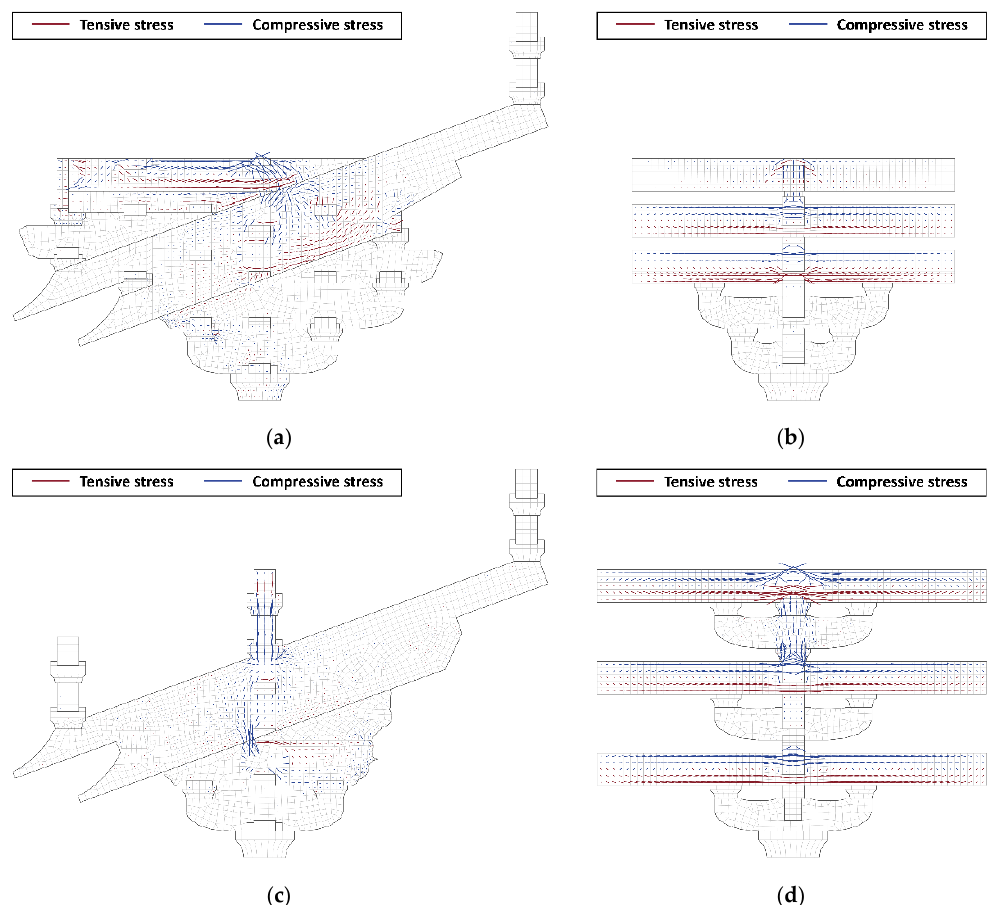
Figure 10. Stress vector diagram of the two Dou-gongs in the collapse case: ( a ) Ji-xin-zao, longitudinal section; ( b ) Ji-xin-zao, transverse section; ( c ) Tou-xin-zao, longitudinal section; ( d ) Tou-xin-zao, transverse section.